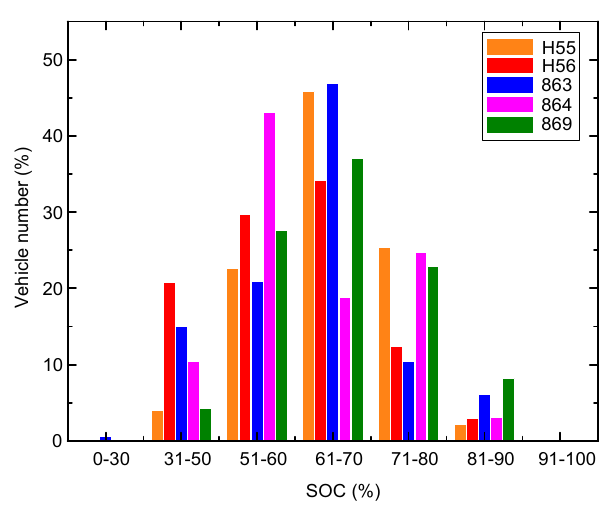
Figure 3. State of charge (SOC) distribution of the returned pure electric buses (PEBs).